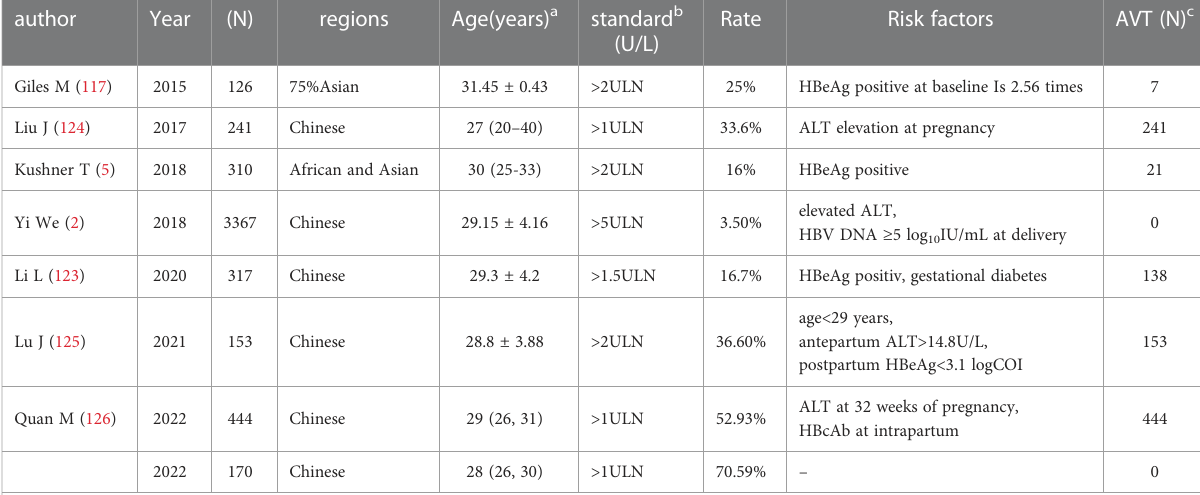
TABLE 1 The characteristics of the references on risk factors of postpartum hepatitis fl